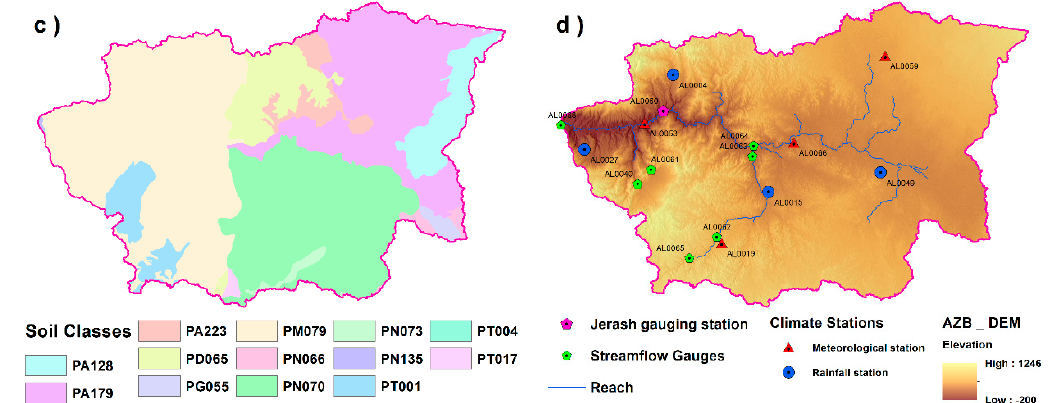
Figure 2. GIS-based parameters used in SWAT modeling, ( a ) Land use/Land cover (LULC) classes, Figure 2. GIS ‐ based parameters used in SWAT modeling, a) Land use/Land cover (LULC) classes, b) Slope Classes, c) Soil classes and d) Main streams and climate stations. ( b ) Slope Classes, ( c ) Soil classes and ( d ) Main streams and climate stations.